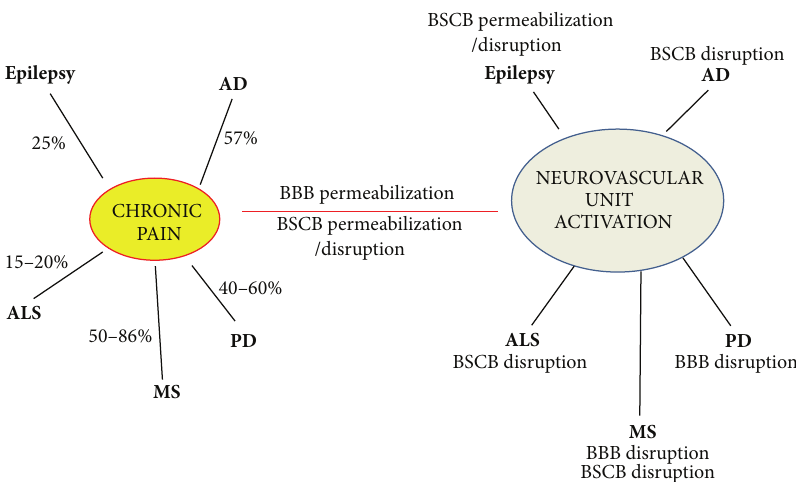
Figure 2: Similarities between chronic pain and NVU activation. Studies from the literature indicate that different NVU components are activated in a given pathology (e.g., epilepsy, Alzheimer’s disease, Parkinson’s disease, multiple sclerosis, amyotrophic lateral sclerosis, chronic pain) with a special focus on BBB/BSCB permeability alterations. Neuroinflammatory/neurodegenerative diseases are associated with chronic pain (see indicated percentages), but further studies are necessary to establish whether NVU activation may represent a “missing link” in the association. While the intrinsic mechanisms relating NVU activation, chronic pain, and neuroinflammatory/neurodegenerative disorders remain unclear, BBB/BSCB permeabilization appears to play a